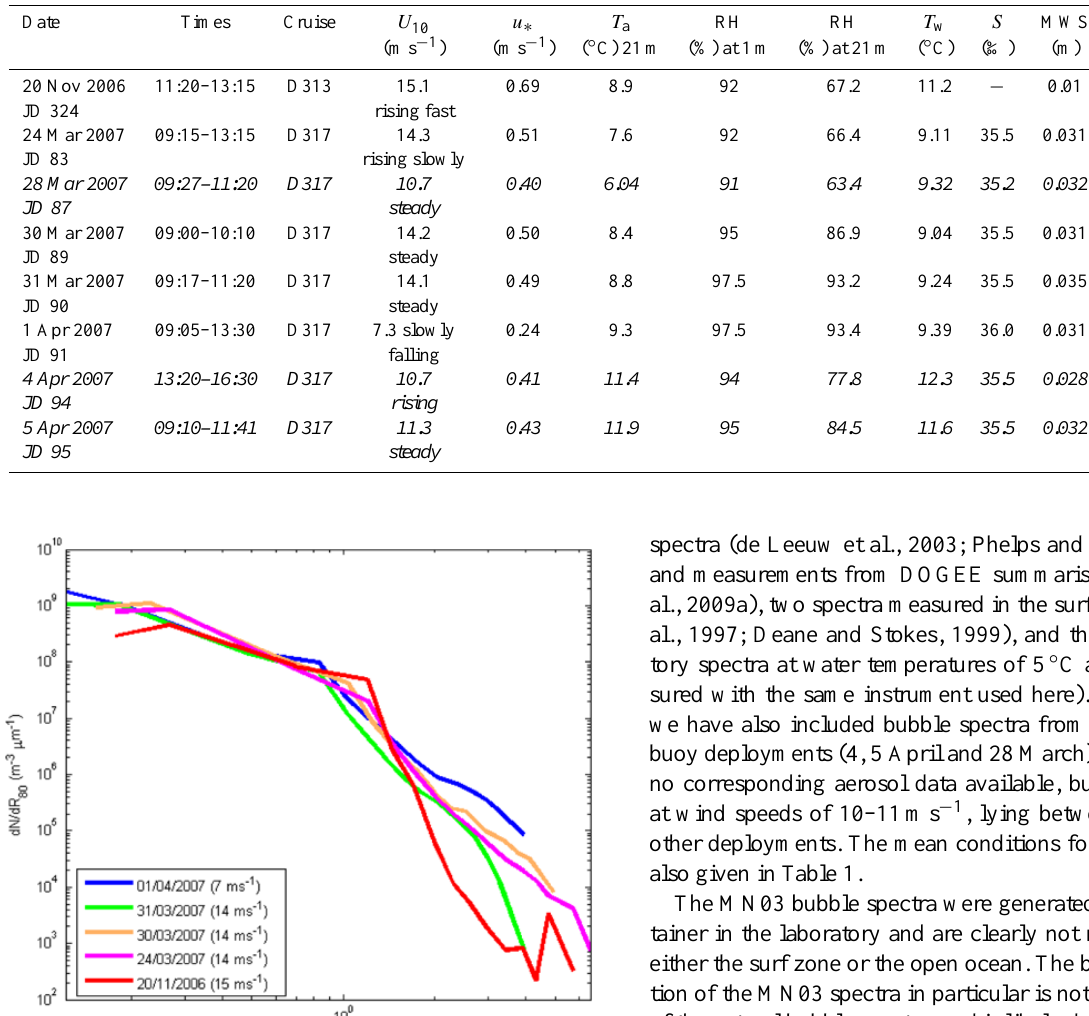
Table 1. Summary of the meteorological and oceanographic conditions including the 10m wind speed, U 10 ; friction velocity, u ∗ ; air temper- ature at 21m, T a ; relative humidity at 1m and 21m; water temperature, T w ; salinity, S ; mean wave slope (MWS); significant wave height, H s ; and whitecap fraction, W . The entries in italics are for buoy deployments where bubble spectra were obtained but no aerosol data are available. The deployment date is also shown in Julian Day (JD) format.